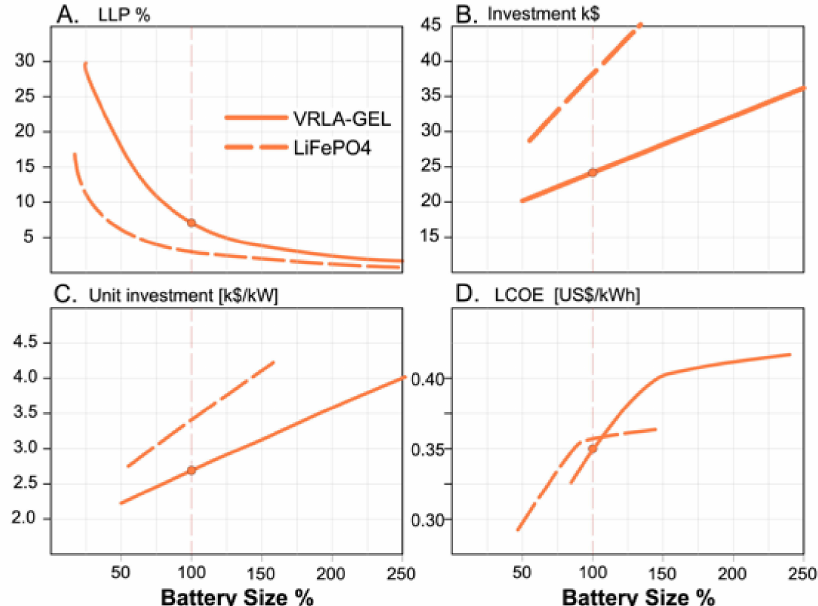
Figure 11. ( A ): LLP for varying battery bank sizes; ( B ): Investment for varying battery bank sizes; ( C ): Unit investment for varying battery bank sizes; ( D ): LCOE for varying battery bank sizes (present situation is shown with a dot). Solid line is for VRLA-GEL; dashed line is the projected behavior for LiFePO4